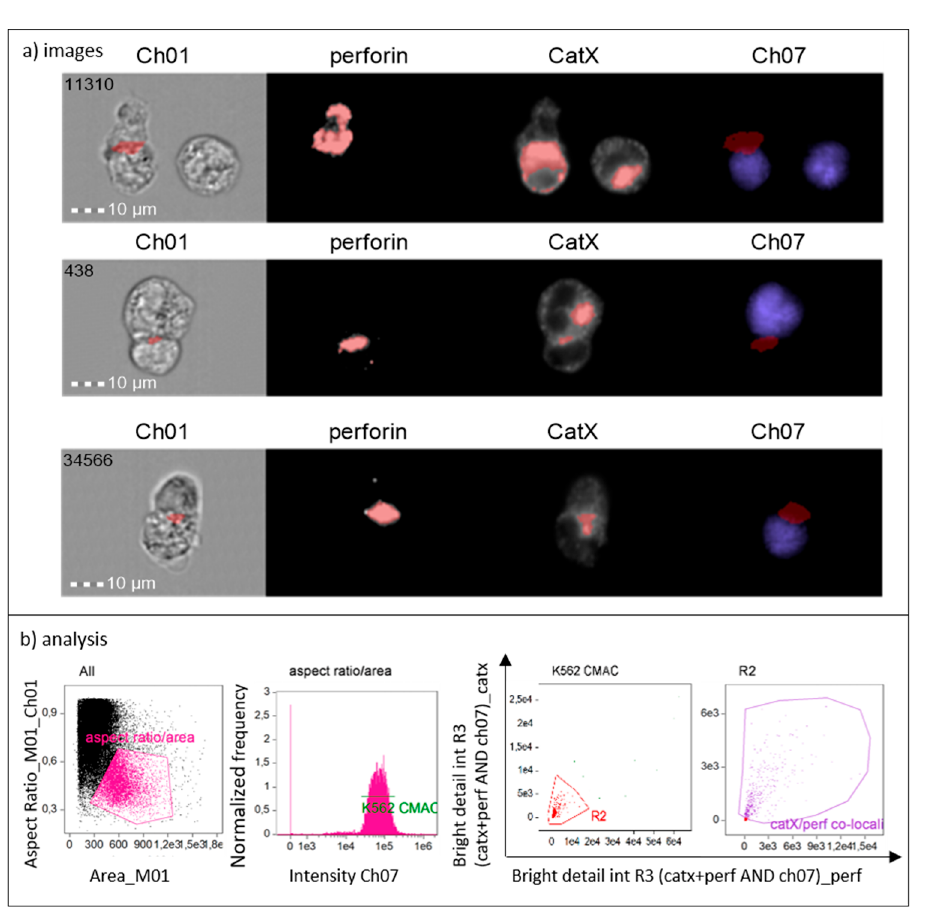
Figure 4. Cathepsin X is released to target cells together with perforin from NK-92 cells during cytolytic attack ( a ). Gating strategy used to isolate the positive events (NK-92 immunoconjugates) and to determine proportion of cells in which cathepsin X co-localizes with perforin ( b ).